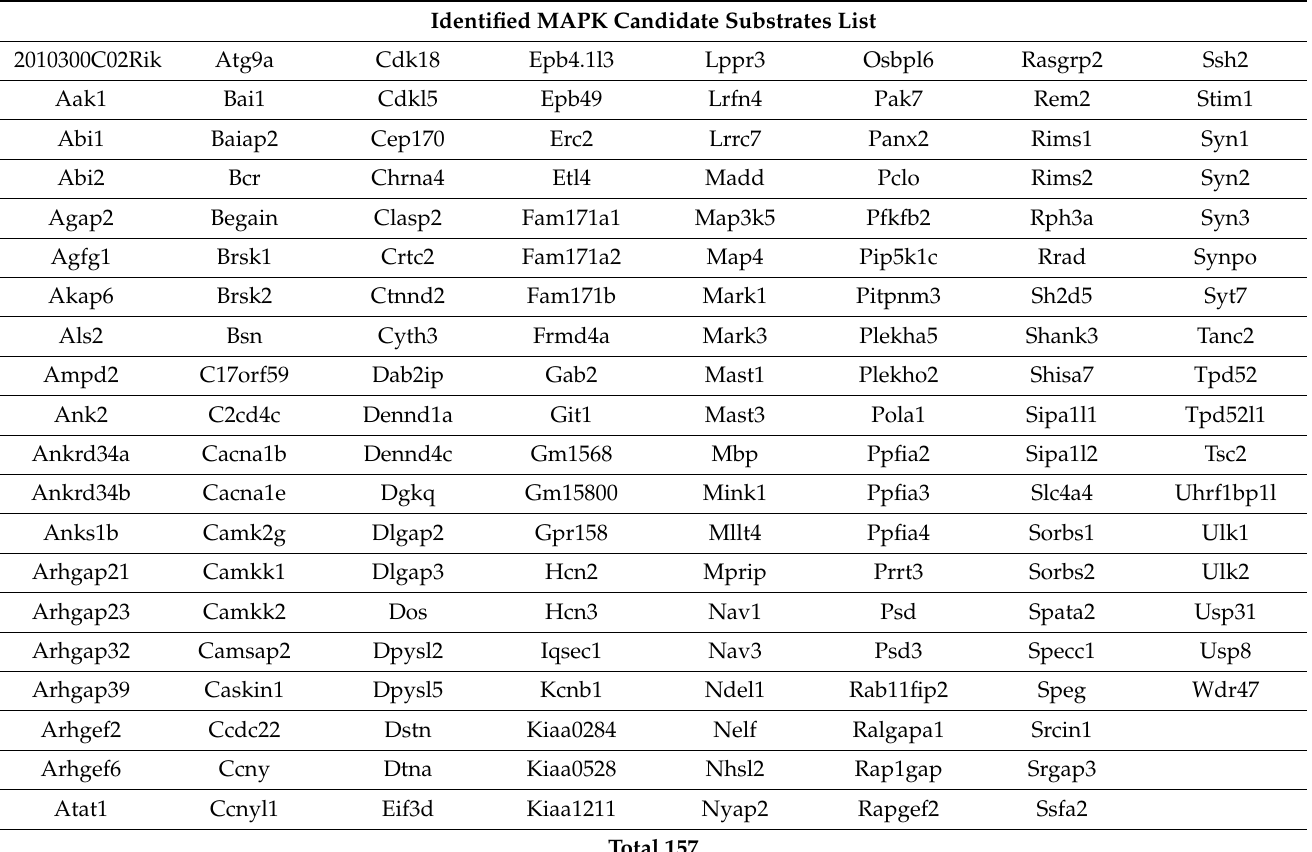
Table 3. List of phosphoproteins identified as a MAPK candidate substrates. Identified MAPK Candidate Substrates